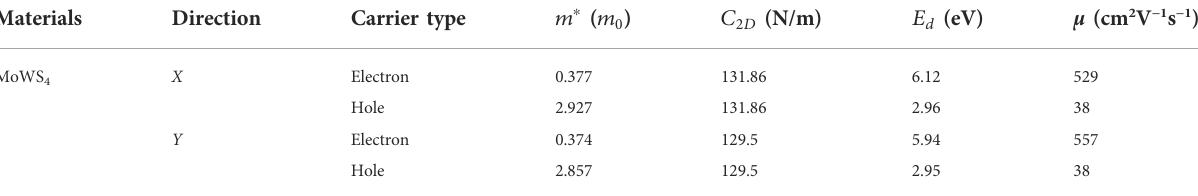
TABLE 1 Carrier effective masses m p , In-plane stiffness C 2 D , Deformation potential constants E d , and carrier mobility μ for MoWS 4 monolayer along the x and y